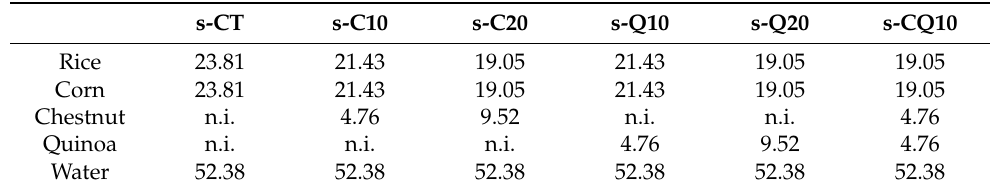
Table 2. Formulations of the experimental sourdough (DY = 210) prepared using rice and corn four substituted from 10 to 20% with quinoa and chestnut flours. Sourdoughs were fermented by Weissella cibaria P9 (initial cell density in dough of 7.0 log10 cfu/g) at 30 ◦ C for 24 h. s-CT s-C10 s-C20 s-Q10 s-Q20 s-CQ10 Rice 23.81 Corn Quinoa n.i. n.i. Water 52.38 52.38 Data are expressed as percentage (%) of total dough weight. n.i., not